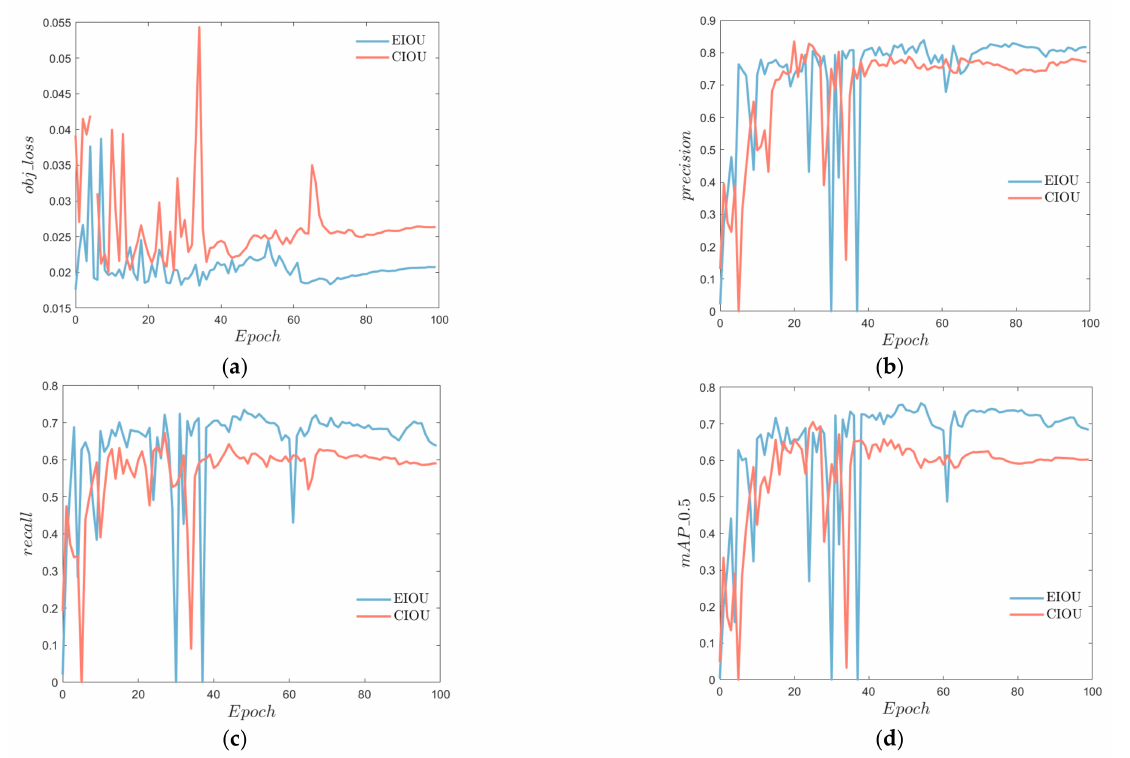
Figure 16. EIOU detection results. ( a ) Target loss. ( b ) Accuracy rate. ( c ) Recalling rate. ( d ) mAP